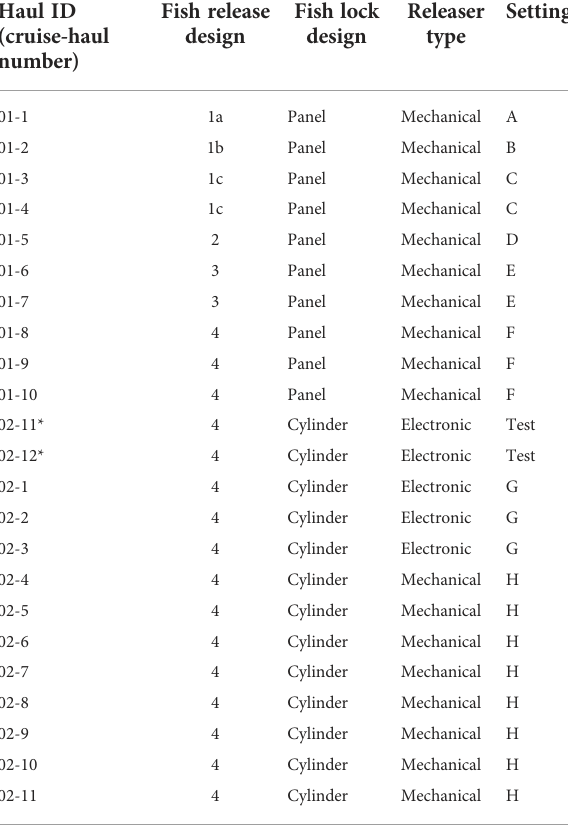
TABLE 1 Overview of the catch limitation system con fi gurations used in the two cruises. Haul ID